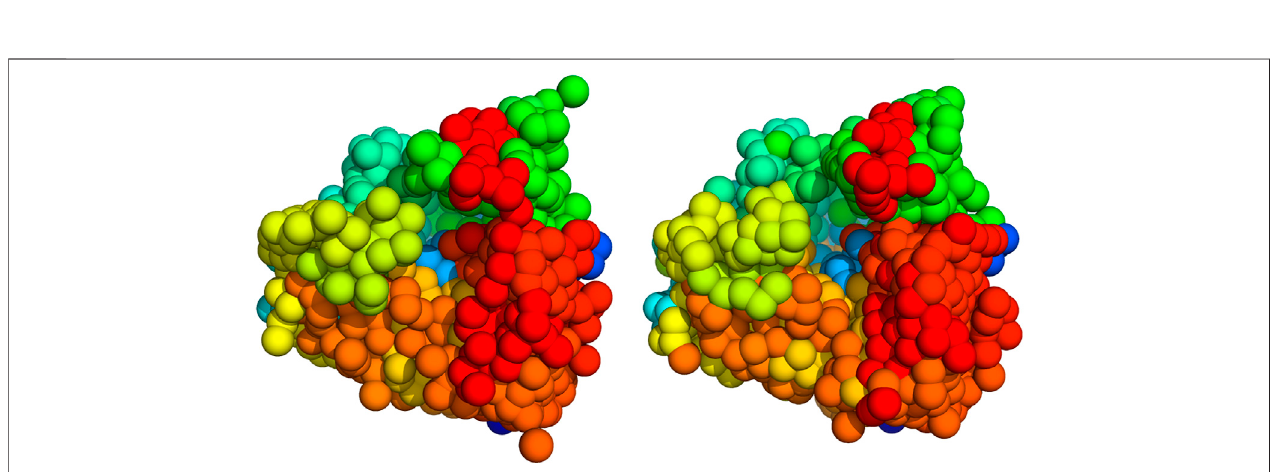
FIGURE 6 | 3D models of the 80S ribosome (Left) 1,000 particle model inferred with Bayesian random tomography (Right) Initial model computed with PRIME. Theparticlesaresortedsuchthatspatiallycloseparticleshavesimilarindices.ByusingPymol ’ schainbowcommand,wecanthenvisualizetheparticlemodelssuchthat substructures are better